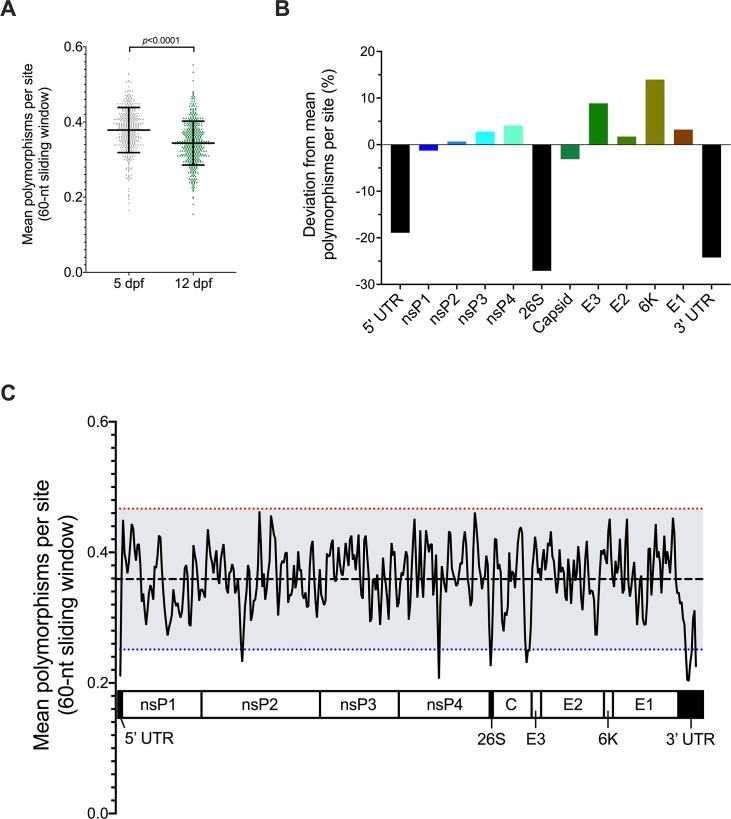
Sequence conservation in untranslated regions (UTR) identified by genome-wide sliding window analysis of mean polymorphisms per site in individual CHIKV infected mosquitoes.Number of polymorphisms per site was averaged across 60-nucleotide (nt) windows in 20-nt steps along the genome. A) Mean polymorphisms per site in all populations from 5 or 12 dpf. Each symbol represents the average of 5 populations in mosquito bodies. Total mean and standard deviation are represented by lines and error bars and were compared by paired t-test, p-value is reported. B) Sliding window values were averaged within each genome element and the percent deviation from the genome-wide mean is presented. C) Mean polymorphisms per site across both 5 and 12 dpf. X-axis is aligned to the CHIKV genome. Red and blue dotted lines are 2 standard deviations above the mean (dashed black line) and represent the cut-off values for mutational hot-spots and cold-spots, respectively.